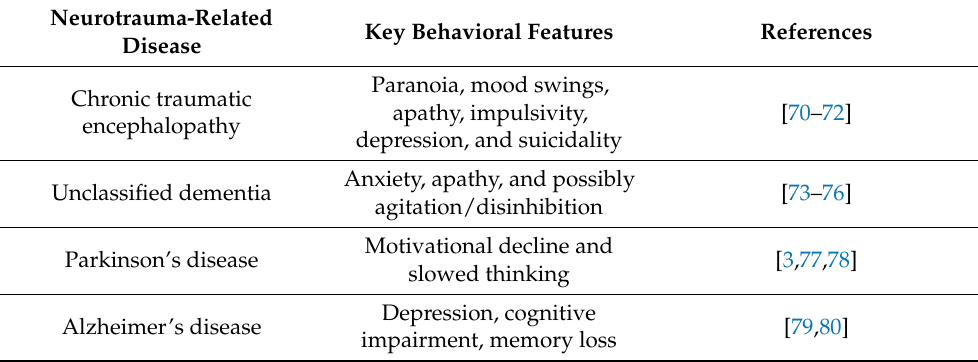
Table 1. Early behavioral symptoms in different neurotrauma-induced